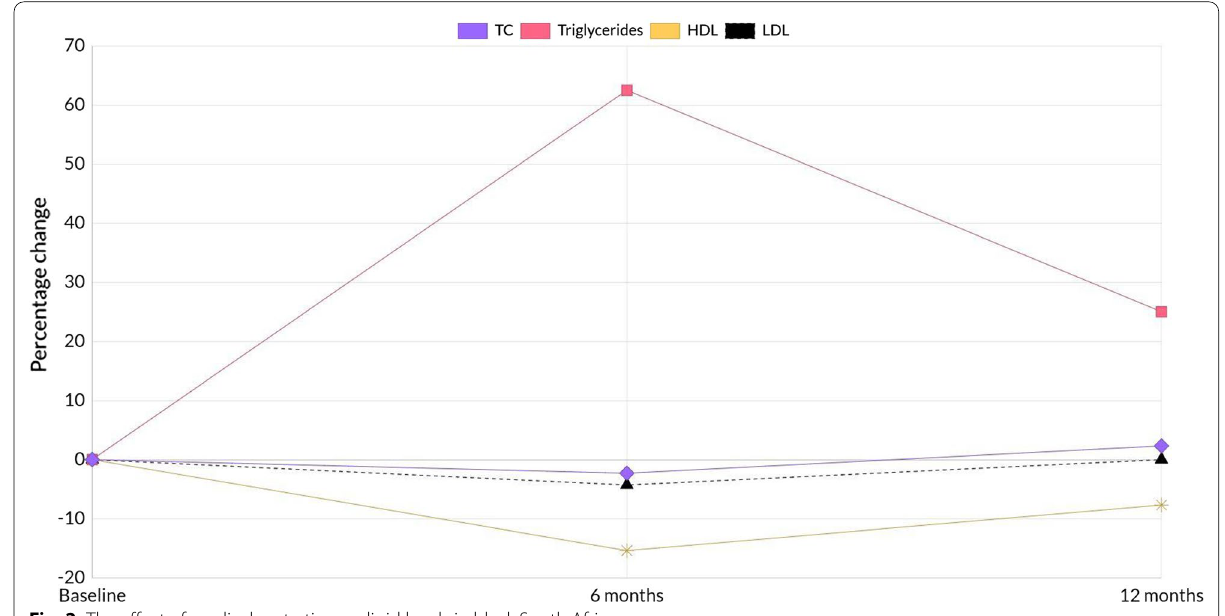
Fig. 2 The effect of medical castration on lipid levels in black South African men